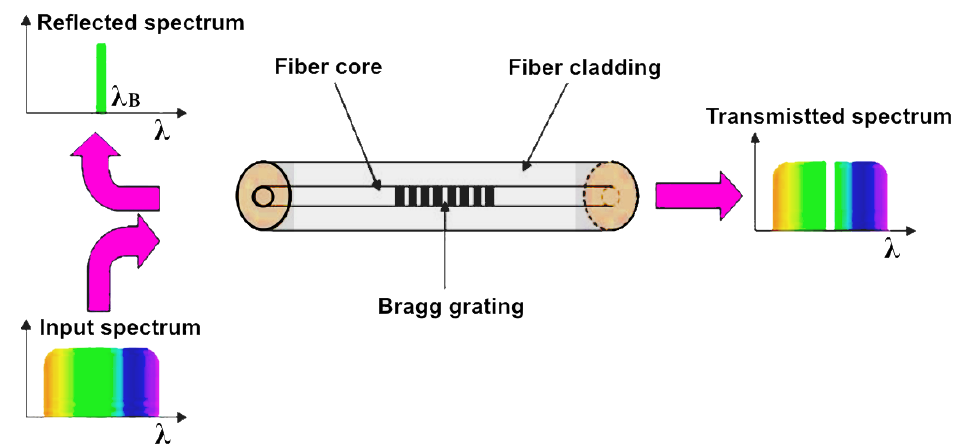
Figure 11. Schematic representation of the principle of Fiber Bragg grating.